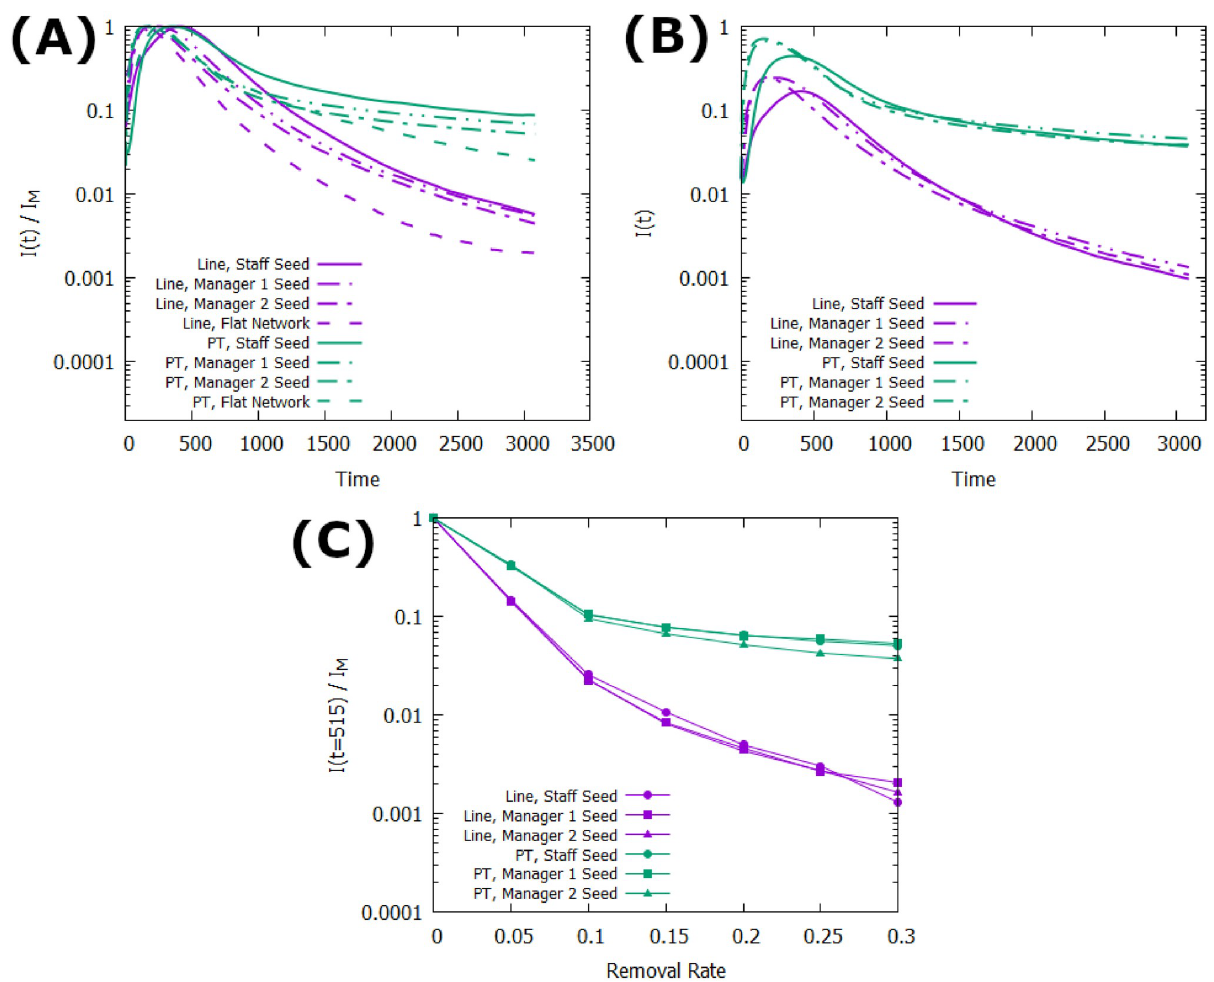
Fig 6. Stability of I population in long-time scenarios. All seeds are size 0.015 N and all data points are averaged over 1000 runs. A: The surviving percentage of the maximum infected population over time. B: The raw percentage of nodes in state I over time. C: Percent of the maximum adopted community remaining at time t = 515 with varying removal